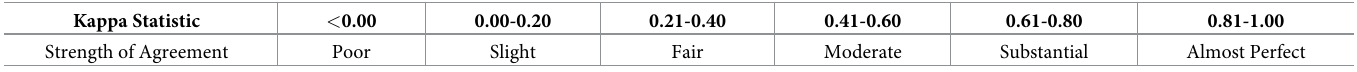
Table 4. Effect evaluation of Kappa